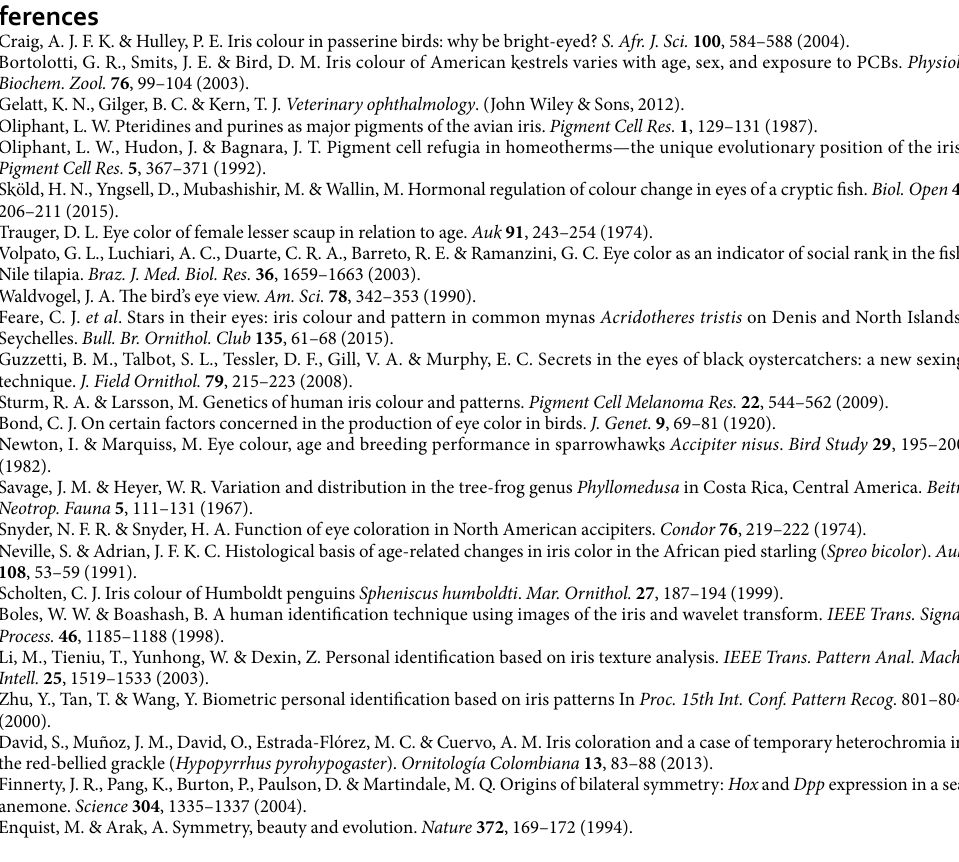
iris flecking asymmetry, total iris flecking and their interaction term were included as explanatory variables. The models were validated by visual inspection of residual plots, which showed no obvious deviation from normality and homoscedasticity. The mean values are presented with standard deviation and the coefficient values of the models are presented with 95% confidence intervals (95% CI) throughout. All statistical tests were conducted in R 3.1.2 58 .